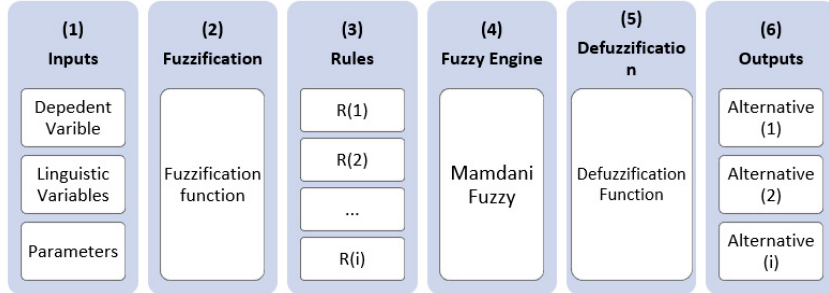
Figure 8. The flow diagram of the proposed FIS.